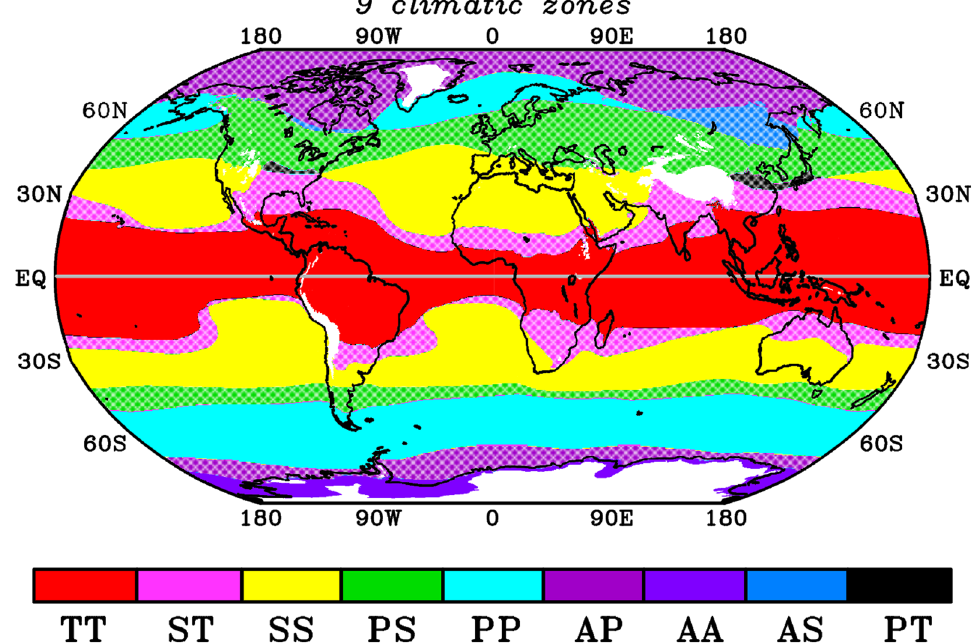
Fig. 7 Global climatic zones obtained by overlapping the air mass zones of the winter and summer half‑years in each hemisphere (Fig. 5; see Table 1 for symbols). The hatched areas indicate the regions where the air mass zones alternate with the season. The blank areas mean the same as in Fig.